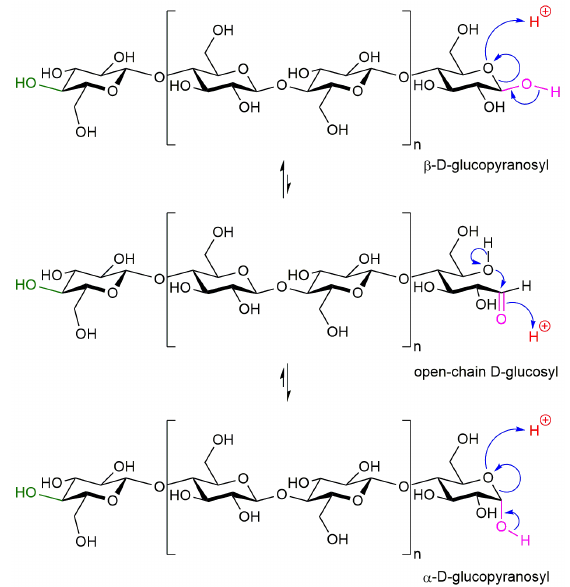
Figure 9. CNCs are composed of several thousands of β ( 1 → 4 ) linked D-glucosyl moieties. The terminal glucosyl moiety undergoes acid catalyzed isomerization. Thereby the functionality of the group which is highlighted in pink changes from hydroxyl to aldehyde. The blue arrows indicate the rearrangement of the chemical bonds. Next to the two shown six-membered cyclic pyranosyl isomers, two five-membered cyclic furanosyl isomers (not shown) could form additionally. Isomerization of the starting glucosyl moiety is not